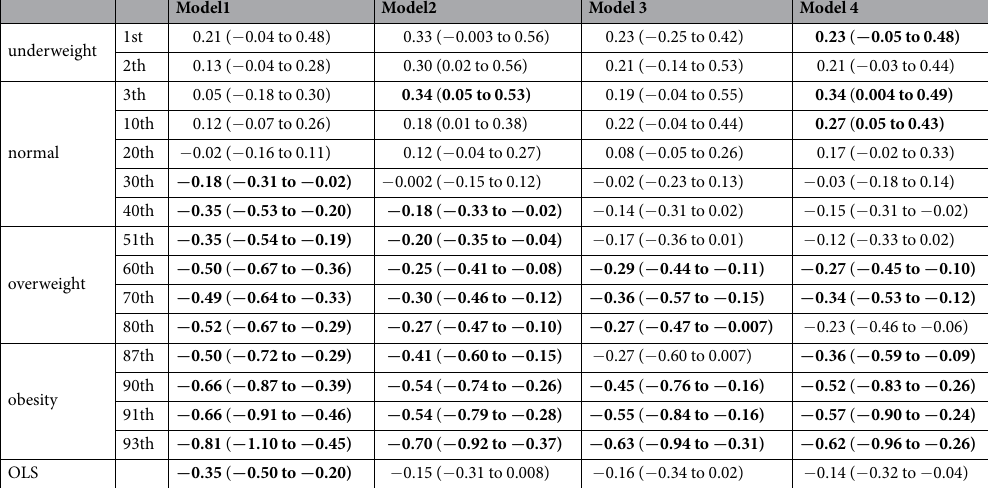
Table 4. Association between vigorous PA and BMI using QR and OLS models for different quantiles of BMI. Abbreviations: PA, physical activity; BMI, body mass index; CI, confidence interval; OLS, ordinary least squares; QR, quantile regression. Values are β estimates (95% CI). Coefficients and CI significant at the 5% level are in